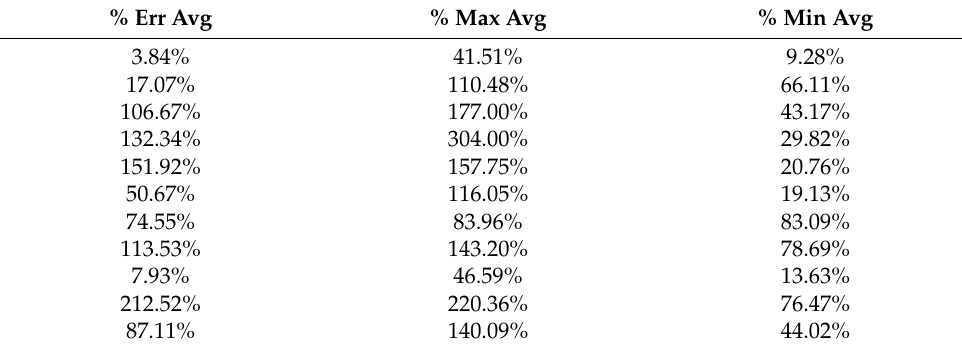
Table A180. Set 3, trials 11–20 data (single 0.5 PR value).